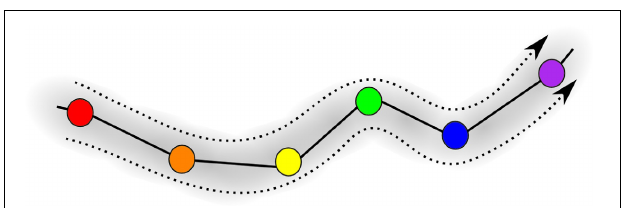
FIGURE 5 | Illustration of the trajectory in an SHC progressing through the sequence of saddle points; different memory patterns are shown in different colors, i.e., red, orange, yellow, green, blue, and violet.